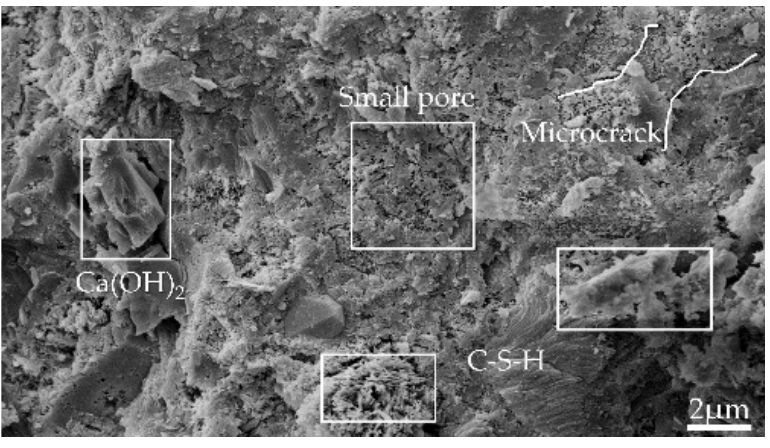
Figure 8. Microtopography and pore structure images of reference group mortar (60 °C).